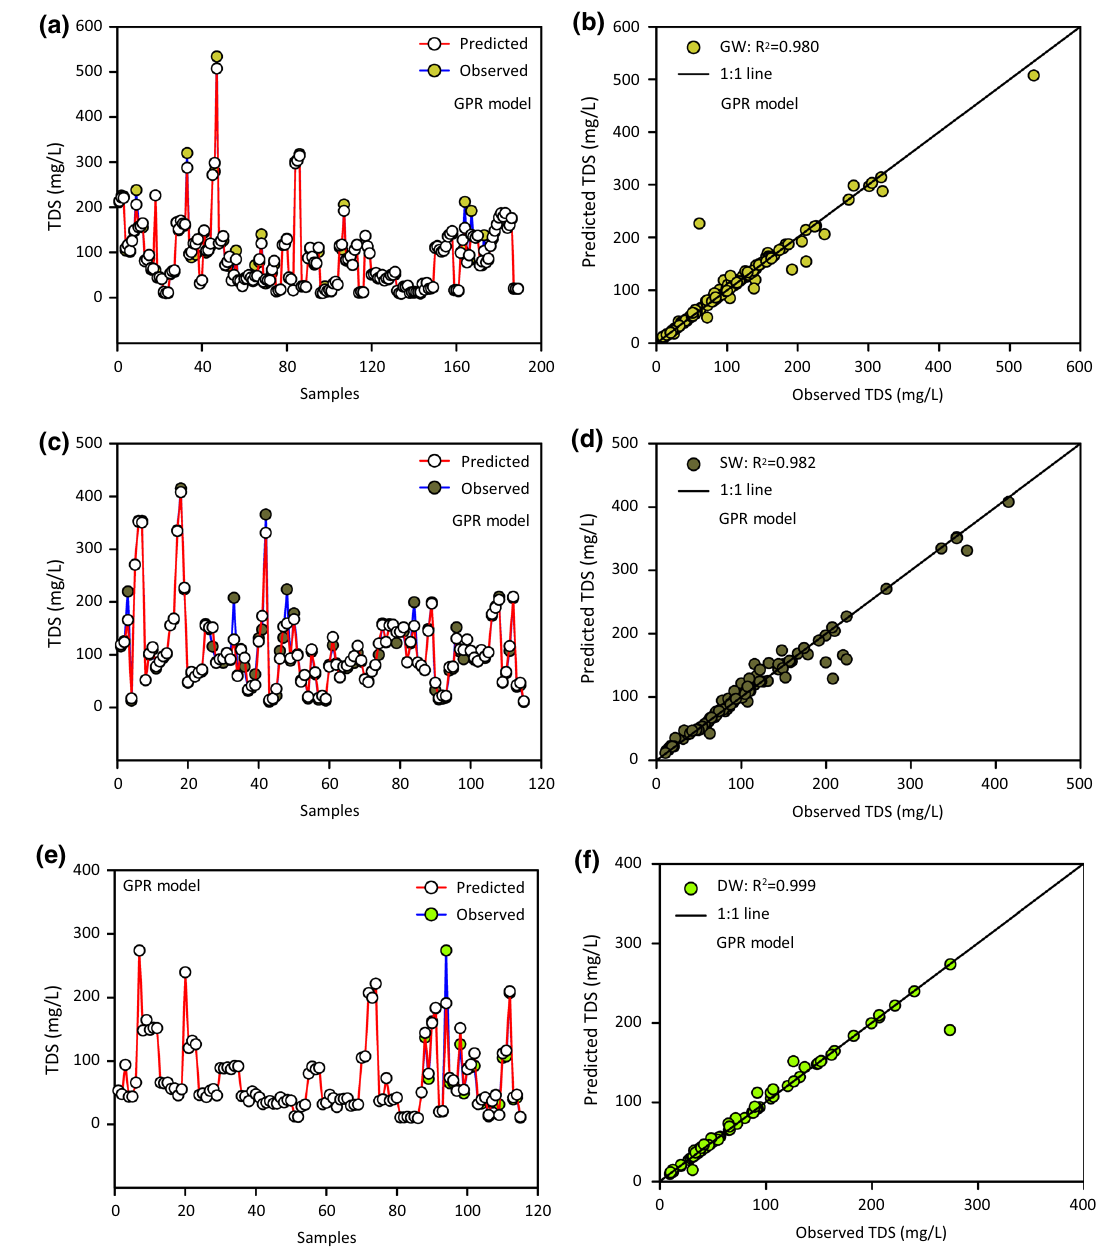
SW; e predicted TDS for each sampling points in DW; and f predicted vs observed TDS in